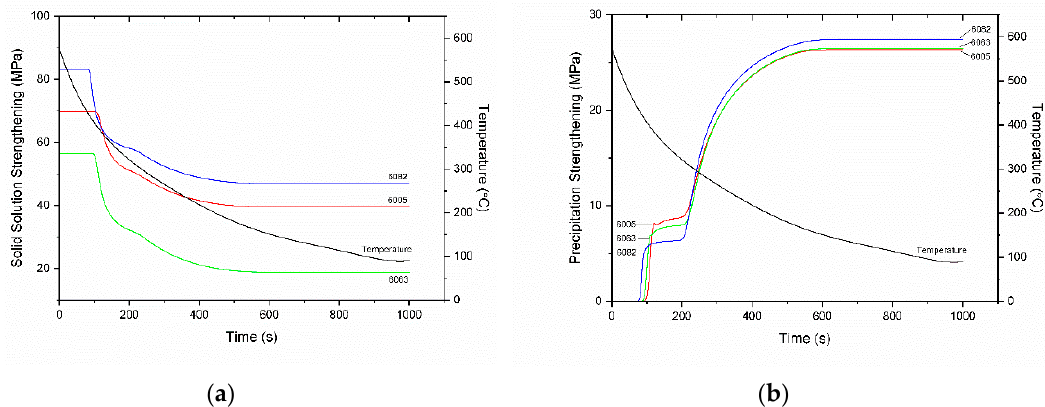
Figure 16. Evolution of solid solution strengthening in ( a ) and precipitation strengthening in ( b ) during homogenization cooling for 6063, 6005, and 6082 alloys. The cooling curve is also indicated.